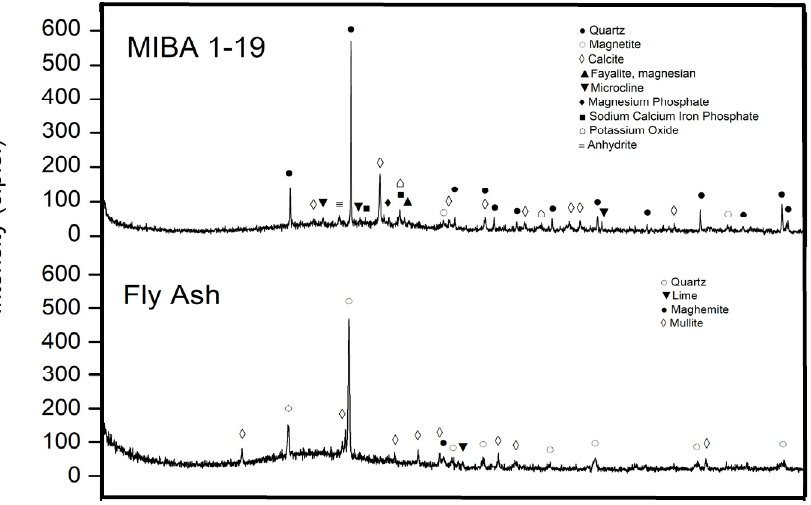
Figure 1. XRD pattern of FA and MIBA.